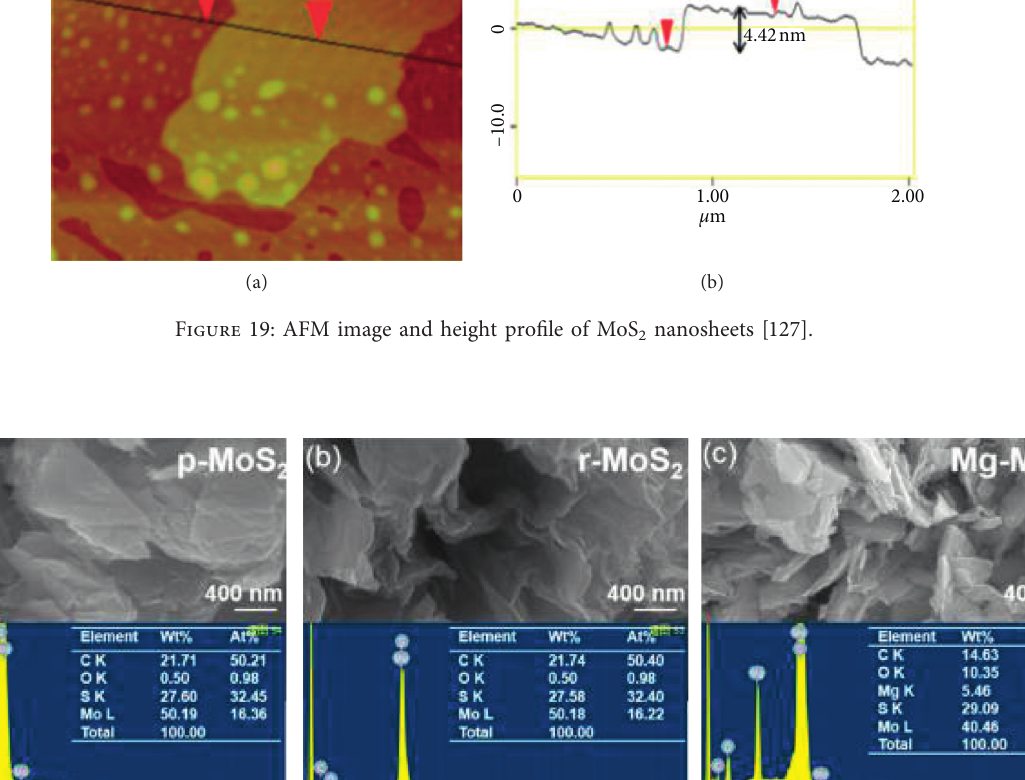
Figure 20: SEM and EDS of (a) pure MoS 2 , (b) restacked MoS 2 , and (c) Mg deposited MoS 2